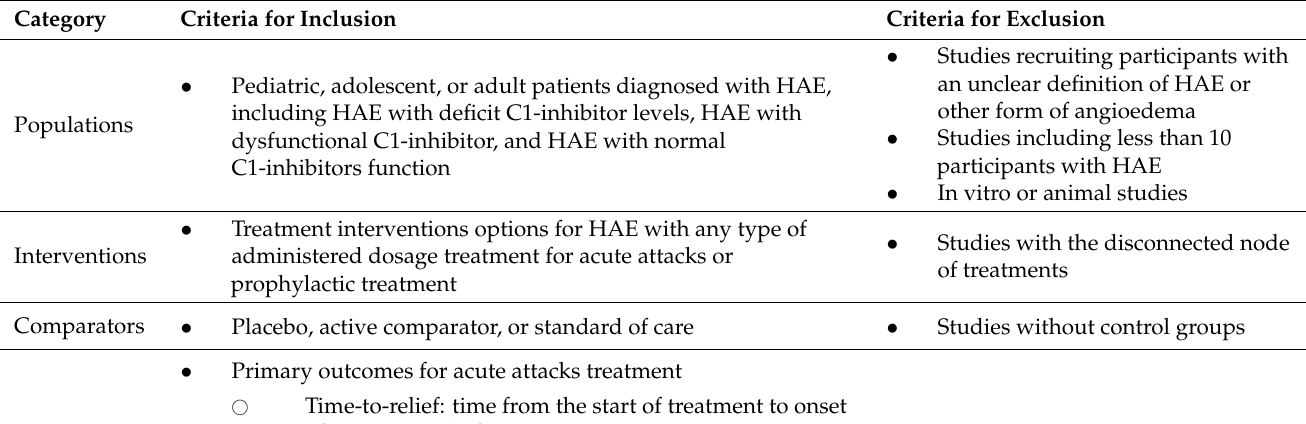
Table 1. The PICOTS: study inclusion/exclusion